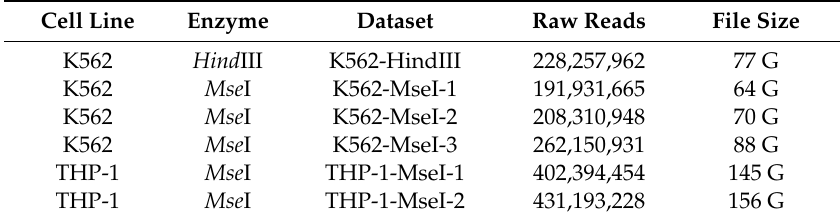
Table 1. The disk space of the test files.